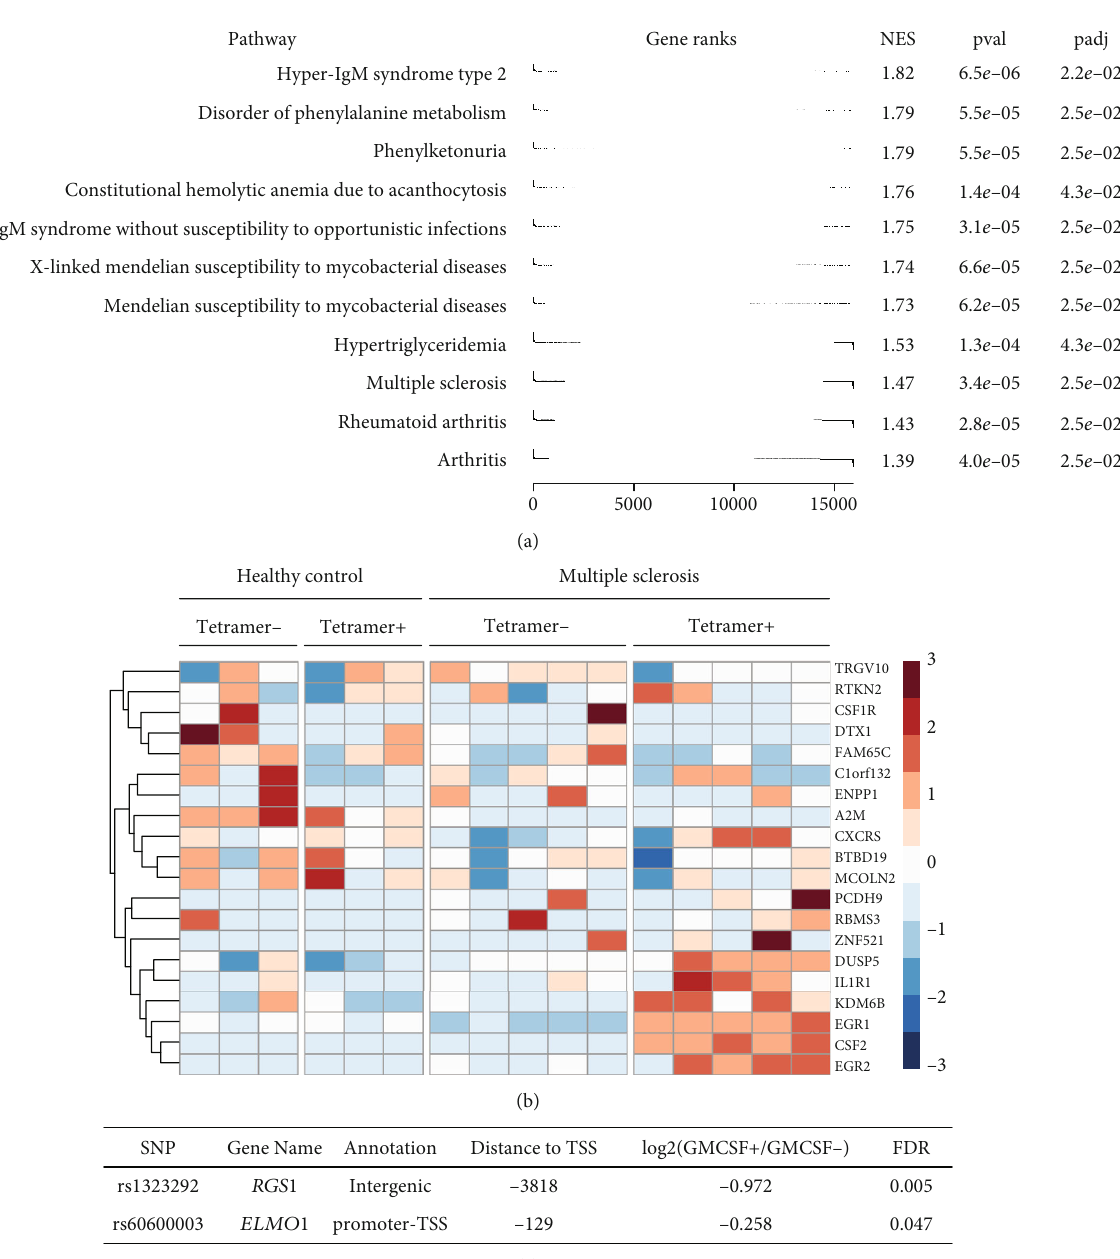
Figure 5: GM-CSF-positive CD4 T cell signatures are associated with autoimmune diseases, especially MS. (a) Gene set enrichment analysis is ð FDR Þ × sign ð log ð GM − CSF+/GM − CSF − ÞÞ function, and the Open Targets database [68] was shown using genes ranked by the – log 10 2 used to provide gene sets associated with diseases. NES: normalized enrichment score; pval: P value; padj: FDR. (b) The heat map ð RPKM + 1 Þ expression values from RNA-seq data of CD4 T cells from MS patients or healthy controls represents the row-scaled log 2 (data from [26]). Groups are separated based on disease status (MS or healthy) and myelin antigen reactivity (reactive: tetramer+). Genes are selected as those identi fi ed in the current RNA-seq study as di ff erentially expressed between GM-CSF-positive versus GM-CSF- ð RPKM + 1 Þ > 0 Þ in at least 4 samples in the data from [26]. (c) Of the 110 established negative cells and having detectable expression ð log 2 non-MHC MS susceptibility variants [70], two SNPs mapped to consensus peaks from the current ATAC-seq study. Information about these SNPs is shown in the table, along with the di ff erential accessibility analysis in GM-CSF-positive versus GM-CSF-negative CD4 T